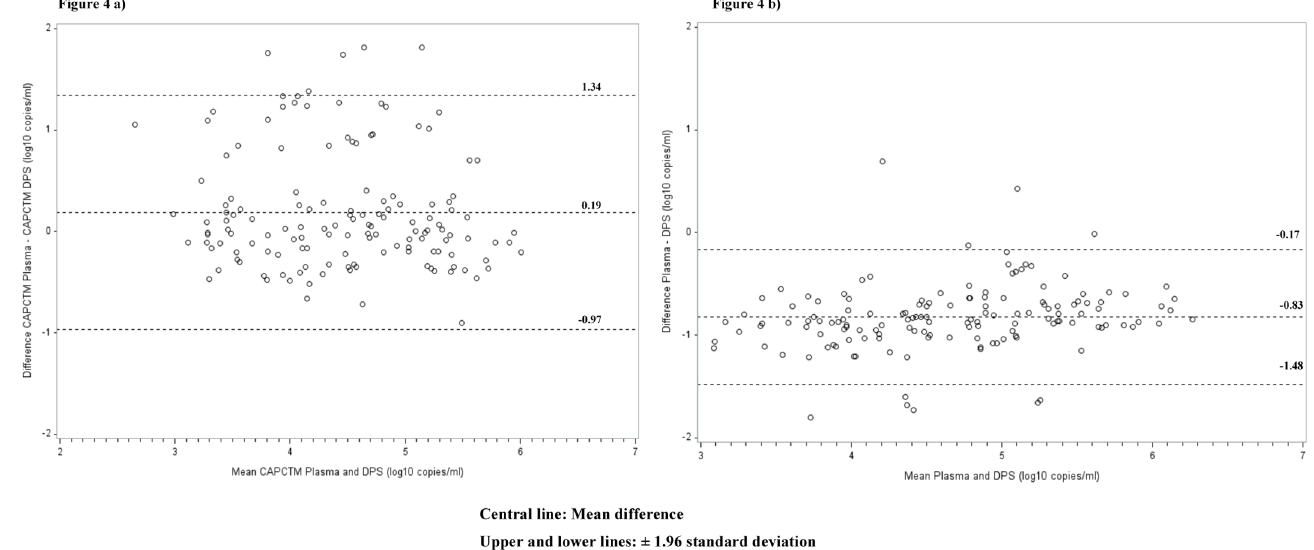
Fig 4. Bland-Altman analyses to evaluate agreementin HIV-1 viral load (VL) quantification among plasma and dried plasma spot specimens collected from patients visiting Nyanza patient support centersand tested with CAP/CTM and Abbott. The difference between the reference and the comparisonspecimentype were plotted against the averageof the reference group and the comparisonspecimentype a ) CAP/CTM DPS VL; b ) Abbott DPS VL.